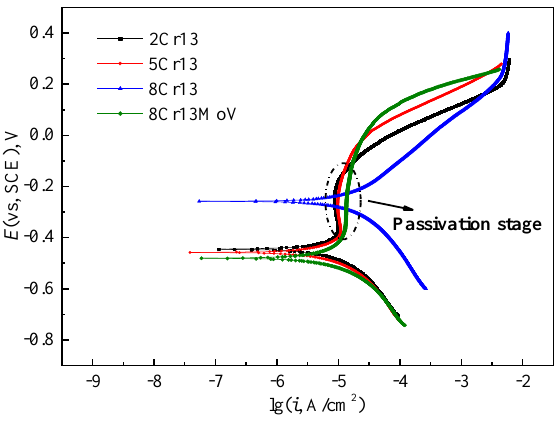
Figure 11. Potentiodynamic polarization curve of the substrate and overlay in 3.5% NaCl solution. Table 8. Electrochemical parameters related to the substrate and each surfacing layer.